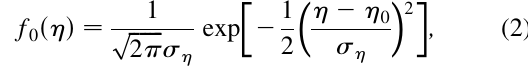
FIG. 1. Approximated normalized gain length L a function of the normalized energy spread (cid:2) ¼ (cid:3) (dashed black). Asymptotic analytical solutions for (cid:2) 2 (cid:2) 1 (blue) and (cid:2) 2 (cid:3) 1